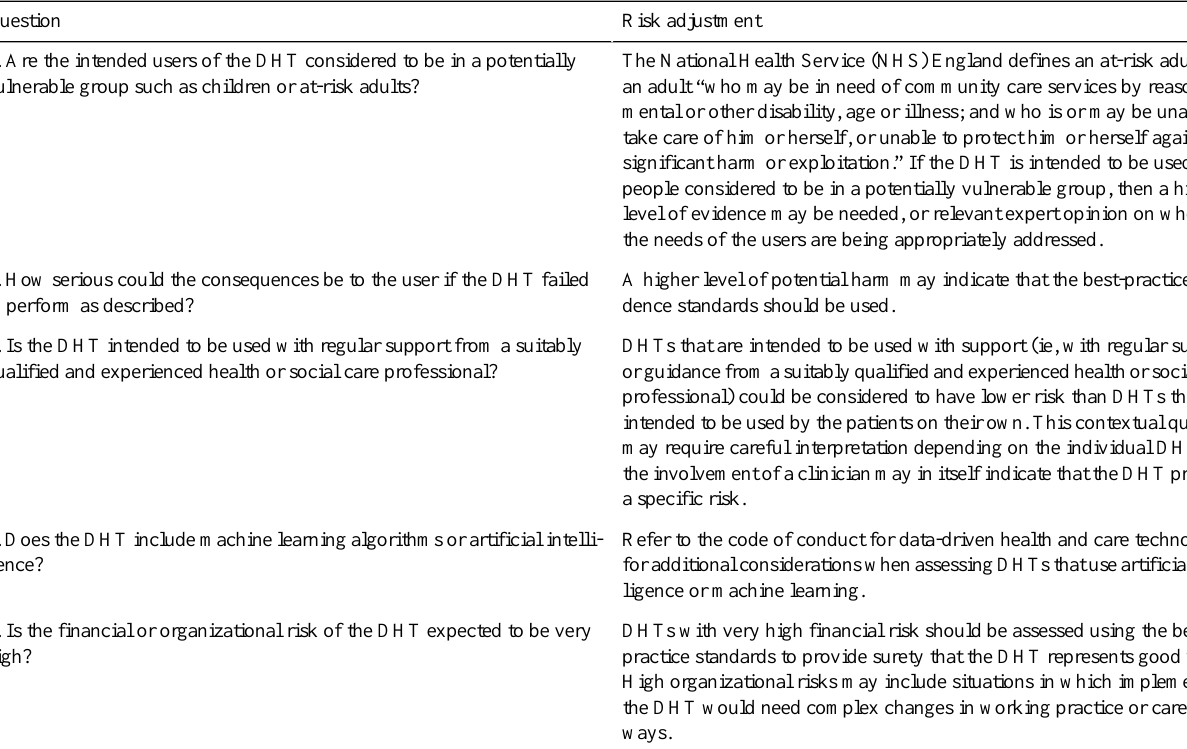
Table 2. Abridged contextual questions to help identify higher-risk digital health technologies (DHTs), abridged from